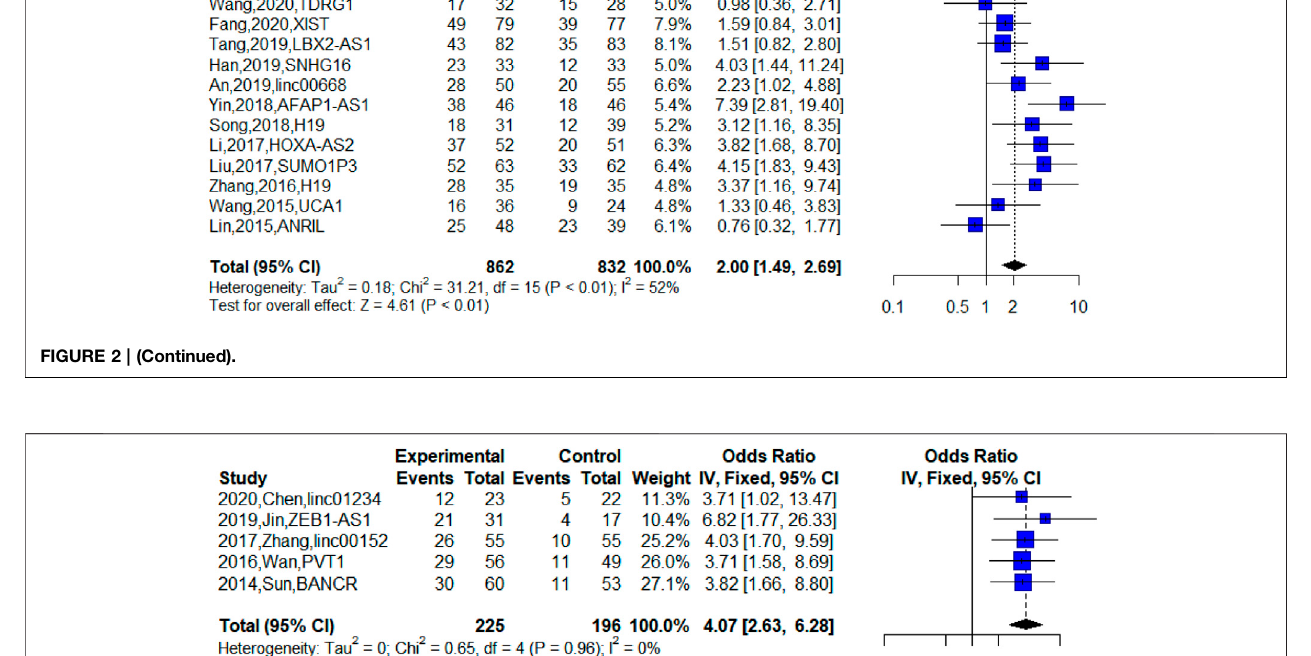
Frontiers in Genetics |